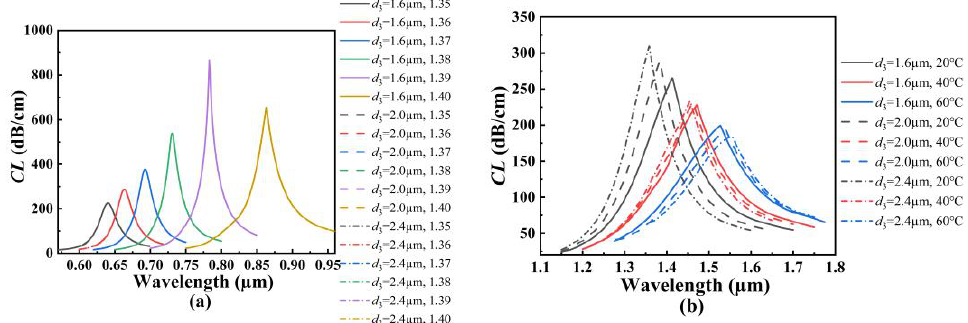
Figure 6. ( a ) The CL spectra of the core mode A when d 3 is set as 1.6, 2.0, and 2.4 μm, and the analyte RI increases from 1.35 to 1.40, respectively. ( b ) The CL spectra of the core mode B when d 3 is set as 1.6, 2.0, and 2.4 μm, and when the temperature is chosen as 20, 40, an d 60 °C , respectively.